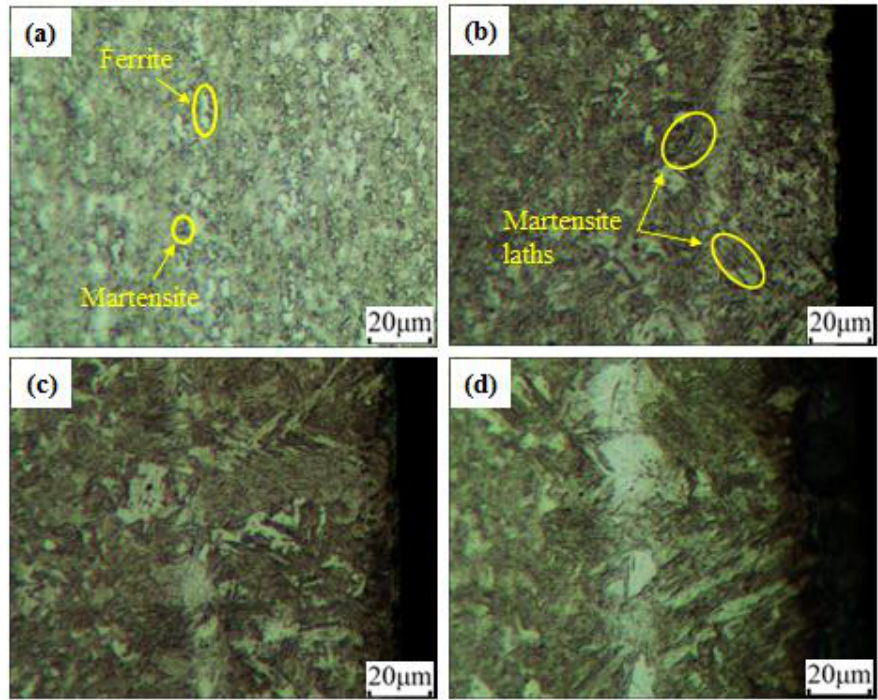
Figure 11. Microstructures of the laser-irradiated zone under different line energies: ( a ) 0 J/mm (unprocessed material); ( b ) 8.25 J/mm (combination 2); ( c ) 18.75 J/mm (combination 4); ( d ) 21 J/mm (combination